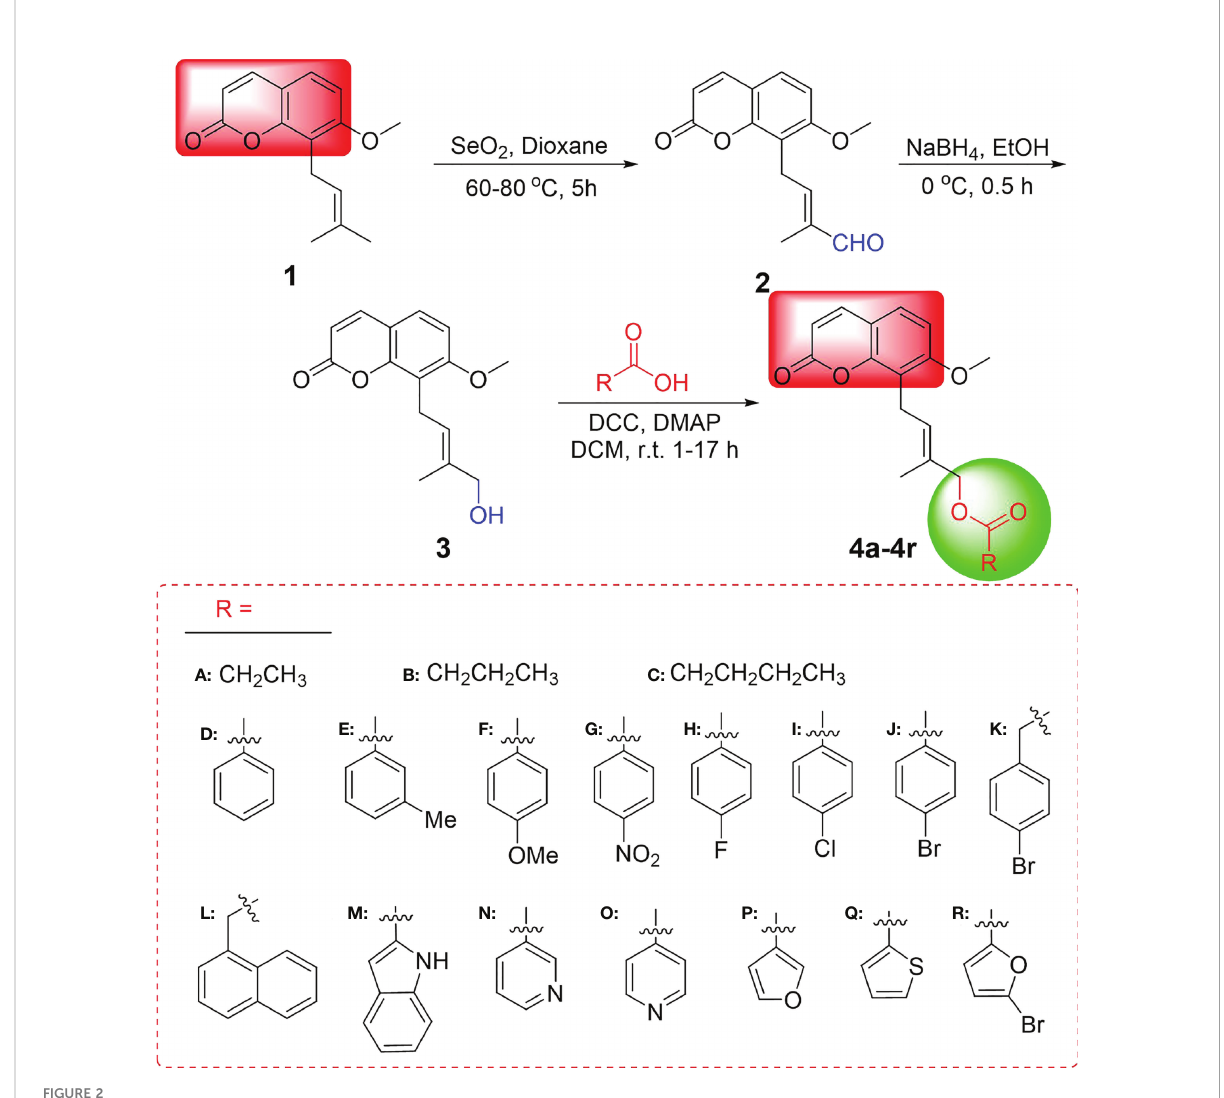
FIGURE 2 Synthetic route for target compounds 4a –